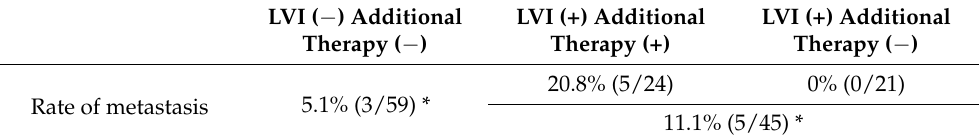
Table 3. The rate of metastasis based on LVI and additional therapy.